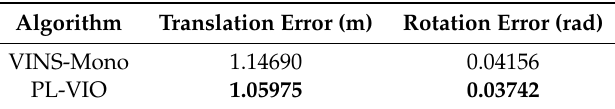
represent the estimated trajectory is more close to the benchmark trajectory.